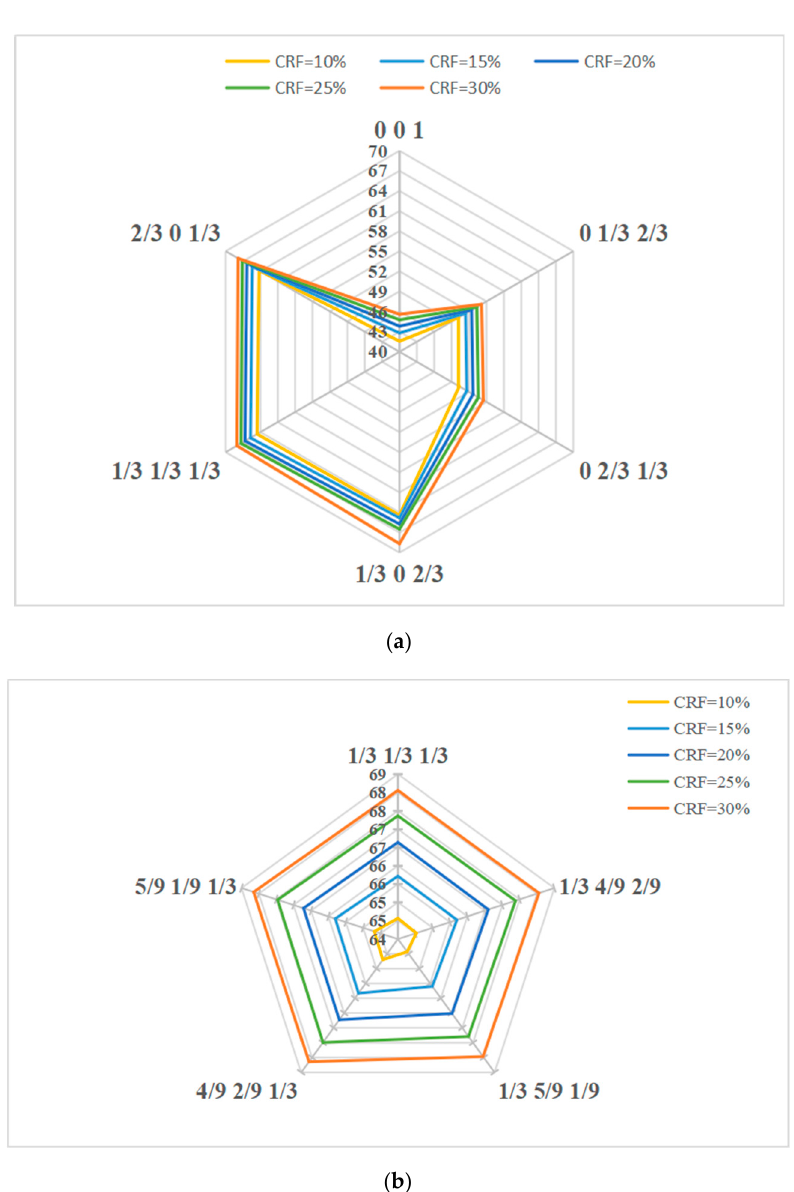
Figure A1. The DPs of different allocation ratio schemes for different given CRF when STWL = 3: ( a ) σ = 0.2m, p =10%; ( b ) σ = 0.2m, p = 5%. The category axis of the radar chart represents the di ff erent schemes of the allocation ratio (e.g., ‘1 / 3 1 / 3 1 / 3’ represents RF 1 = RF 2 = RF 3 = CRF / 3), and the value axis represents the corresponding DP. Partial allocation ratio schemes are shown in Figure A1 for different conditions.